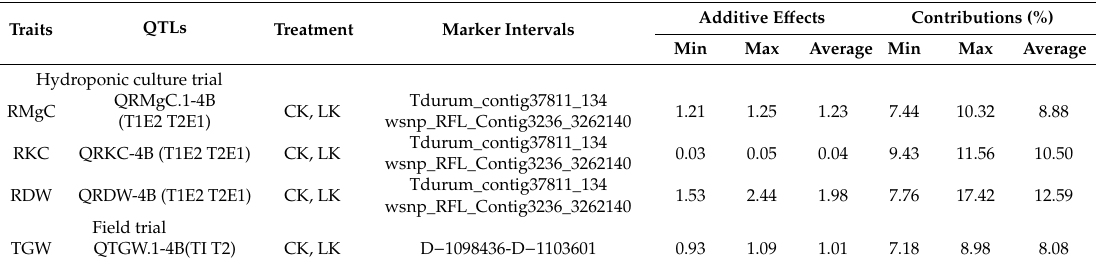
Table 4. RHF-QTLs detected in more than two treatments under the hydroponic culture trial and field trial.